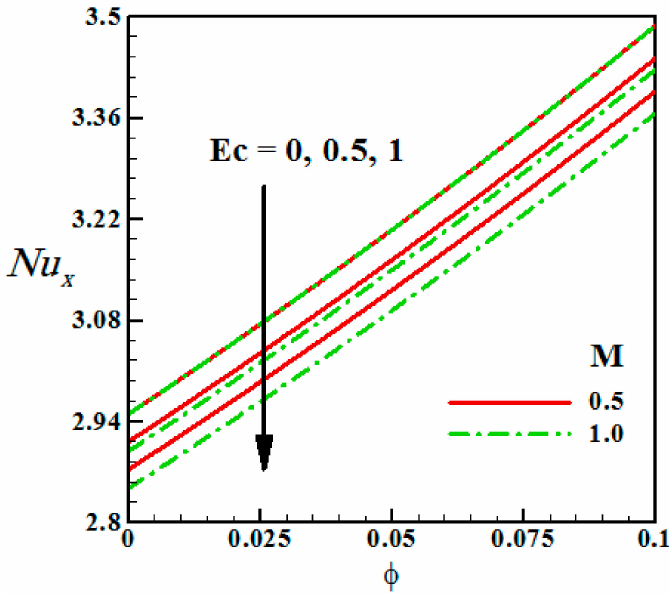
Figure 4. Effect of Eckert number ( Ec ) and Magnetic parameter ( M ) on the local Nusselt number Nu x